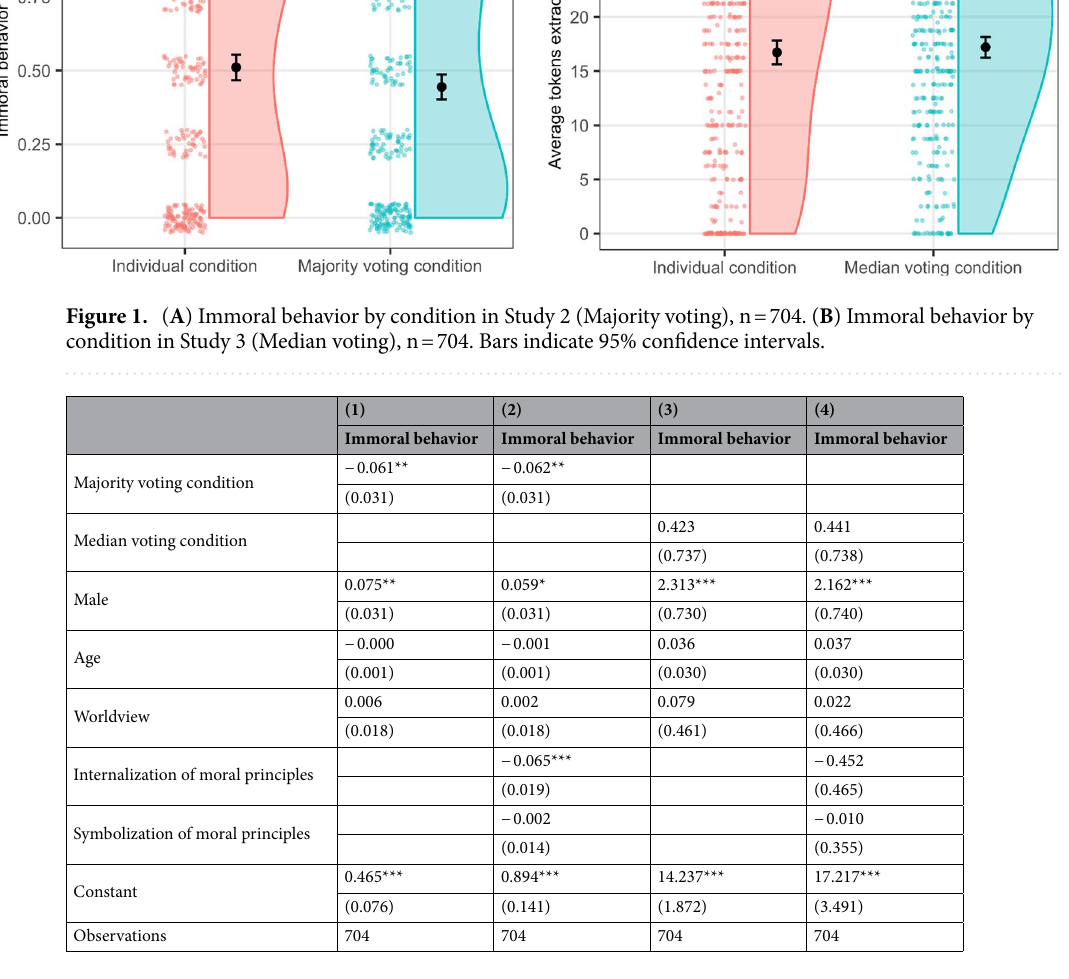
Table 2. The effect of majority voting (Study 2) and median voting (Study 3) on immoral behavior. All regressions are ordinary least squares. The dependent variable in model (1) and (2) is the mean value of how much participants extract from the donation across the four moral decisions (0 = do not extract anything from the donations, 1 = extract the full amount of 30 tokens across all four organizations). The dependent variable in model (3) and (4) is the mean value of how much participants extract from the donation across the four moral decisions (0 = do not extract anything from the donations, 30 = extract the full amount of 30 tokens across all four organizations). Worldview score is a continuous variable (ranging from 6 to 24), where 6 is the most collectivistic score and 24 is the most individualistic score. Internalization of moral principles is a continuous variable (ranging from 1 to 7), where a high score indicated that moral principles are central to one’s self- concept. Symbolization of moral principles is a continuous variable (ranging from 1 to 7), where a high score indicated that moral principles are expressed outwardly to others to a high degree. *** p < 0.01; ** p < 0.05; * p <